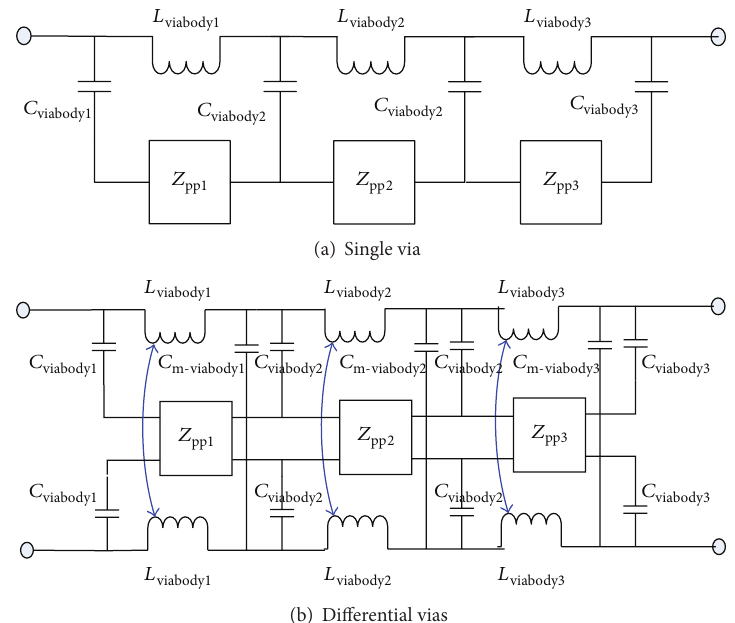
Figure 7: Equivalent circuit model of the vertical via structure in multilayer.